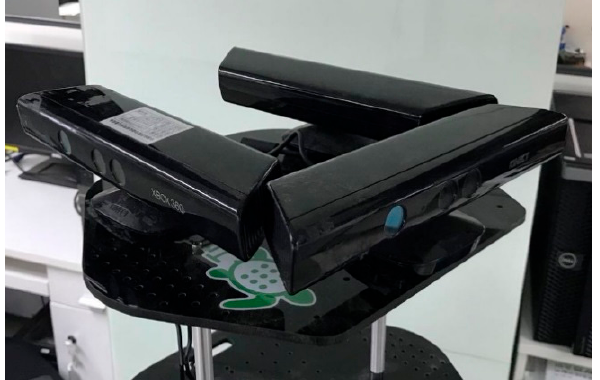
Figure 1. Example of three-Kinect arrangement.